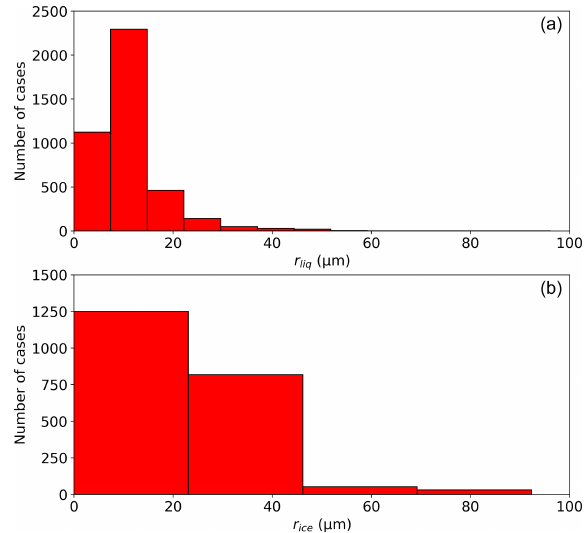
Figure 7. Distribution of retrieved effective radii for liquid water droplets (a) and ice crystals (b) . The bin width is set to the sum of the root-mean-square error from Table 3 and the errors discussed in Sect. 4.5. In each instance, only cases are considered in which the phase fractions are above 0 . 1 (liquid water fraction for r liq and ice water fraction for r ice ). This results in 4111 of 4590 cases for r liq (89 . 6%) and 2153 of 4590 cases for r ice (46 .